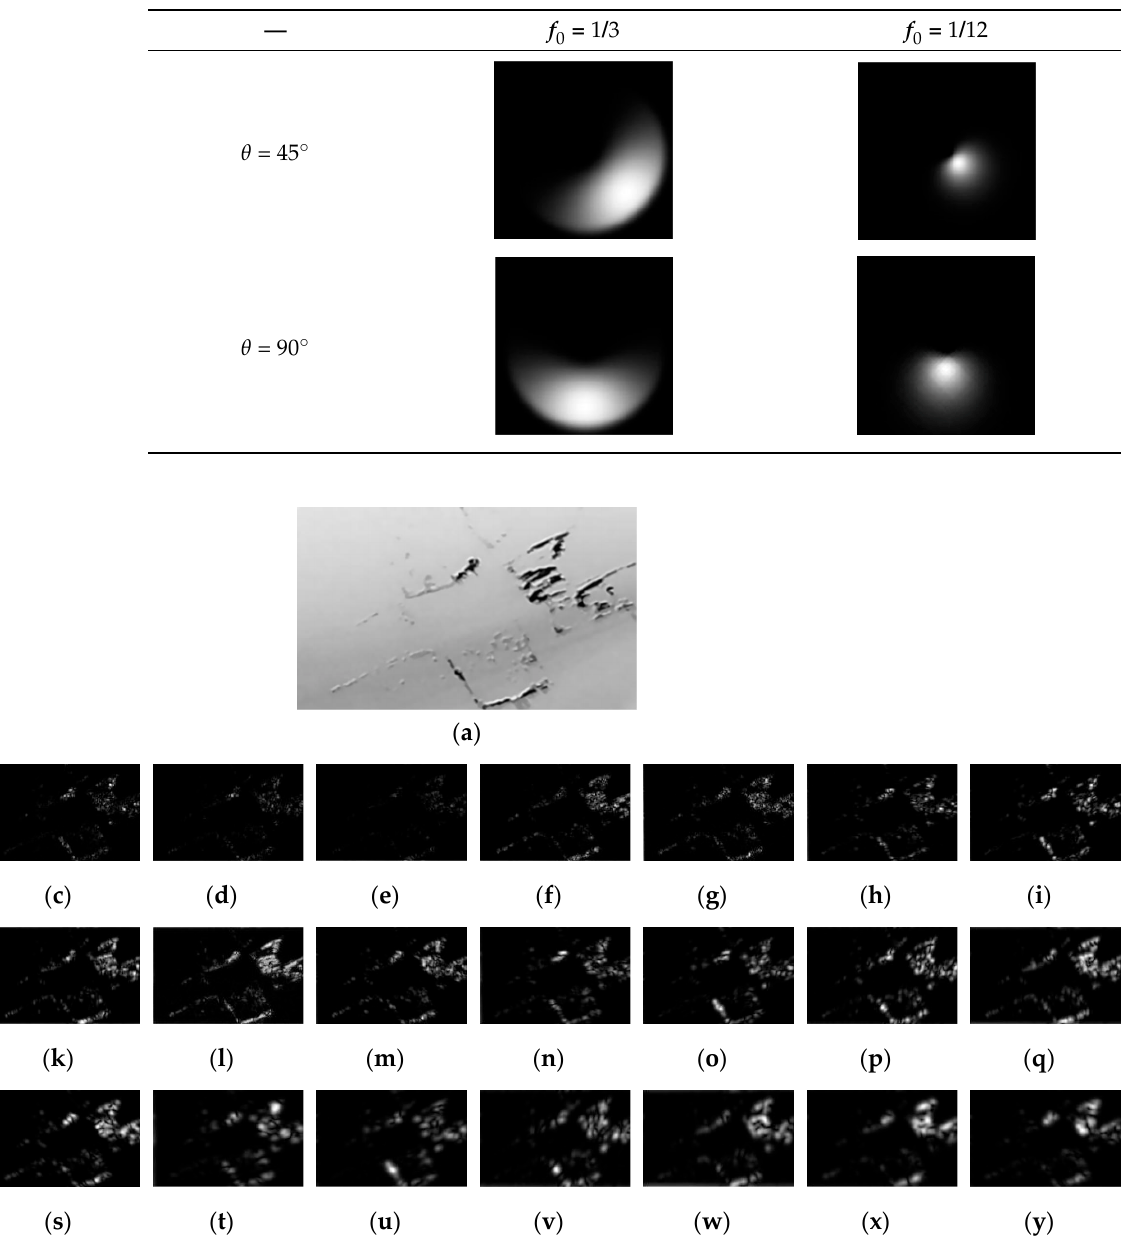
Table 2. The template of the log-Gabor filter. — —